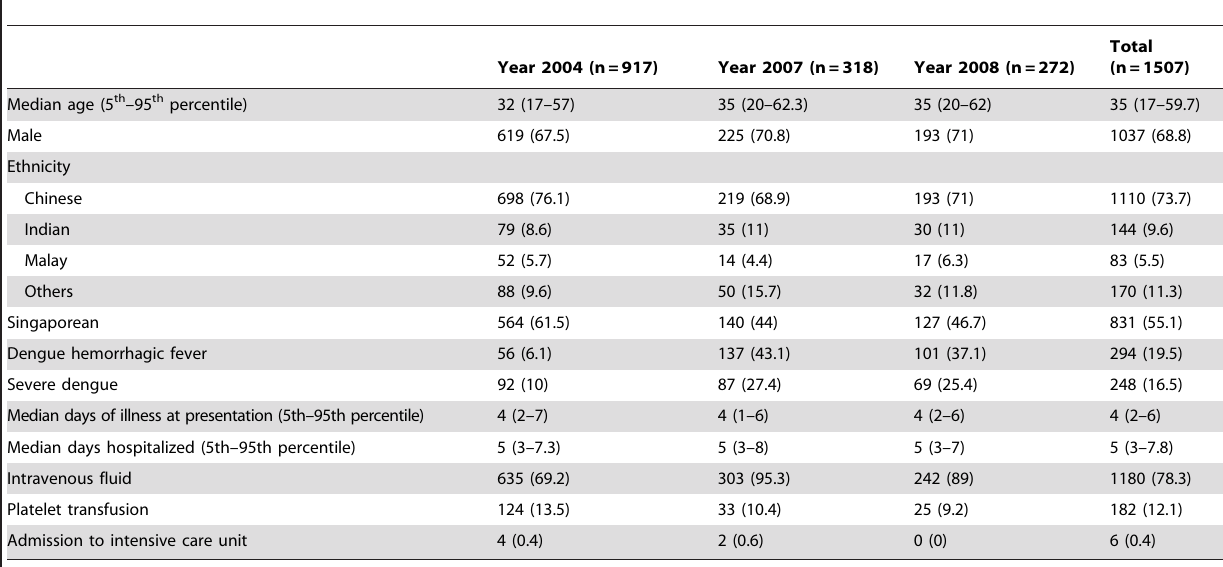
Table 1. Demographic and clinical characteristics, treatment and clinical outcomes of adult dengue patients with positive dengue polymerase chain reaction.